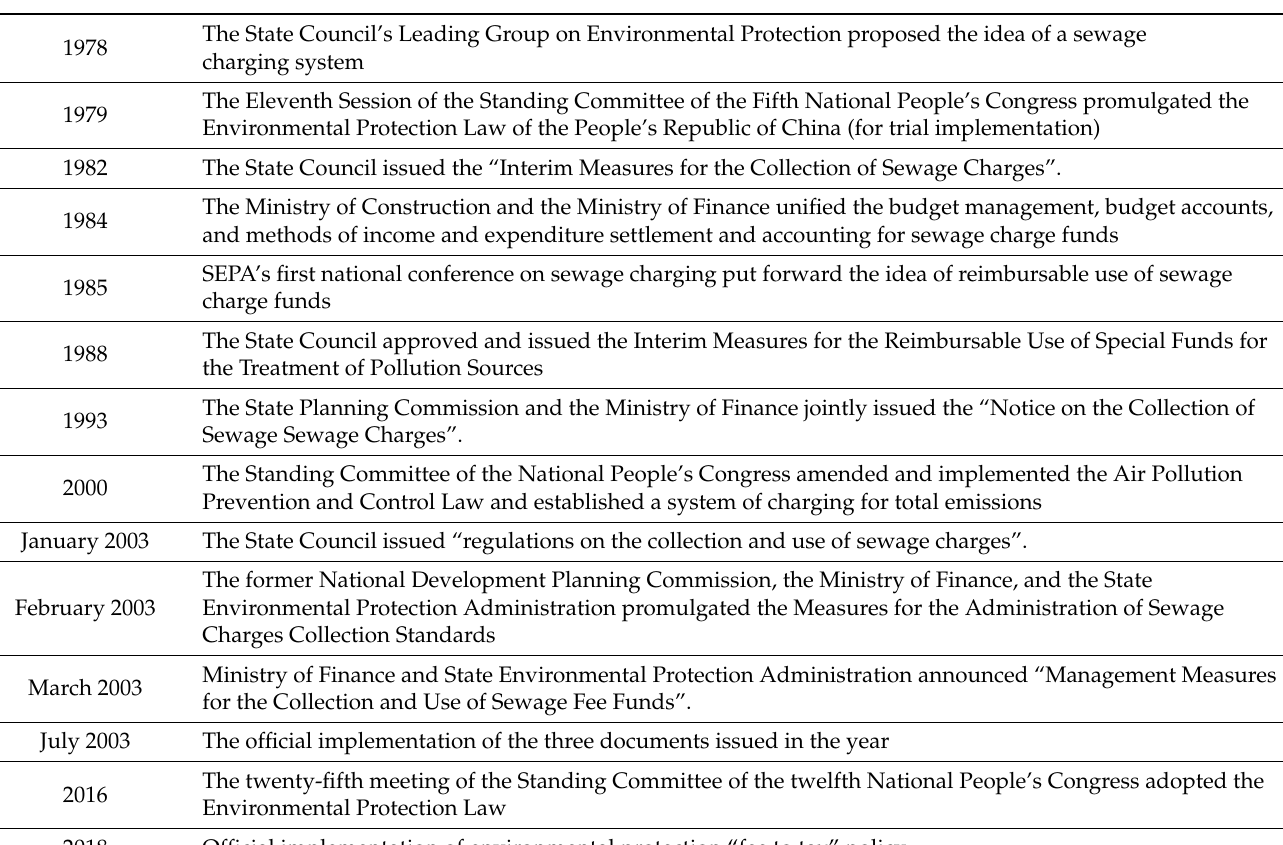
Table 1. History of Changes in China’s Environmental Protection Tax